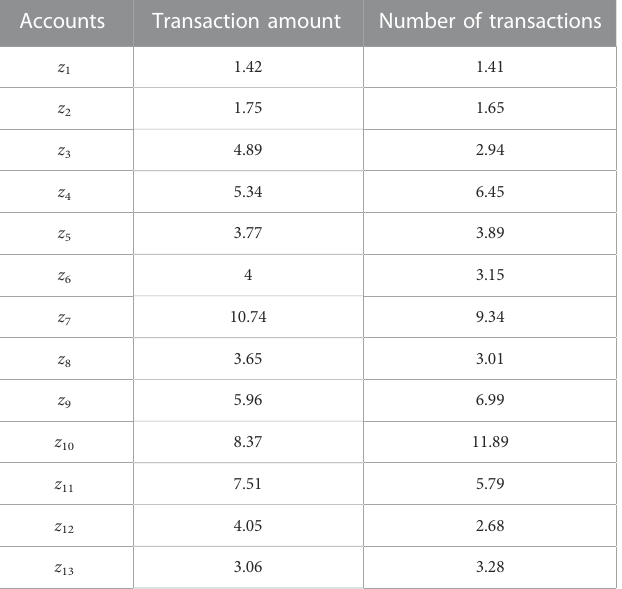
TABLE 4 The cubic fuzzy values related to relation B